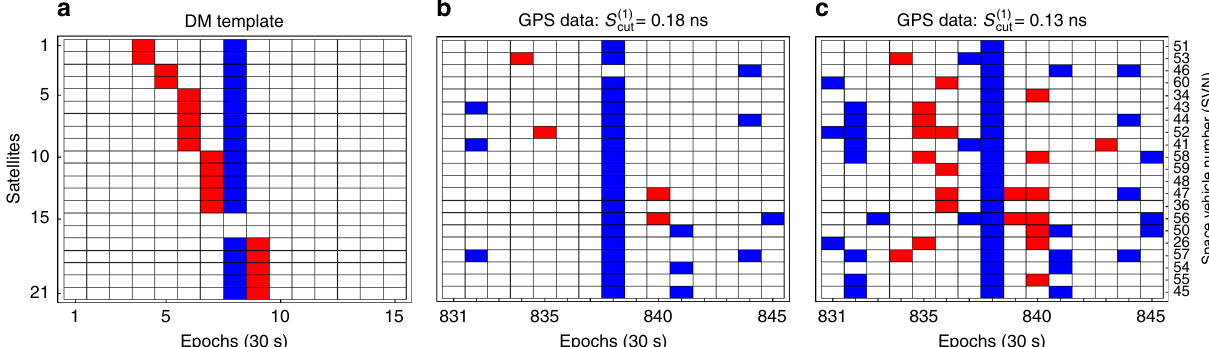
Fig. 3 Correlated dark matter signal across satellite network. a One of the expected pseudo-frequency S (1) signatures for a thin domain wall. Red (blue) tiles indicate positive (negative) dark matter-induced frequency excursions, while white tiles mark the absence of the signal (c.f. Fig. 2). In this example, the satellites are listed in the order they were swept (though in general the order depends on the incident direction of the dark matter object and is not known a priori), and Γ eff > 0 in Eq. (1). The slope of the red line encodes the incident velocity of the wall. The reference clock was swept within the 30 s leading to epoch 8. Satellites 15 and 16 do not record any frequency excursions, since they are spatially close the reference clock and are swept within the same 30 s period. b , c Show S (1) atomic clock data streams for all operational Rb Global Positioning System satellite clocks for 21 May, 2010 for a 15 epoch window. ¼ 0 : 18 ns and 0.13 ns, respectively. At the 0.13 ns level, c , this data Red tiles show data points with S ð 1 Þ > S ð 1 Þ , and the blue depict S ð 1 Þ < (cid:3) S ð 1 Þ , with S ð 1 Þ cut cut cut window would be fl agged as a potential event, but not at the 0.18 ns level shown in b . In this case, the potential event c is excluded because the